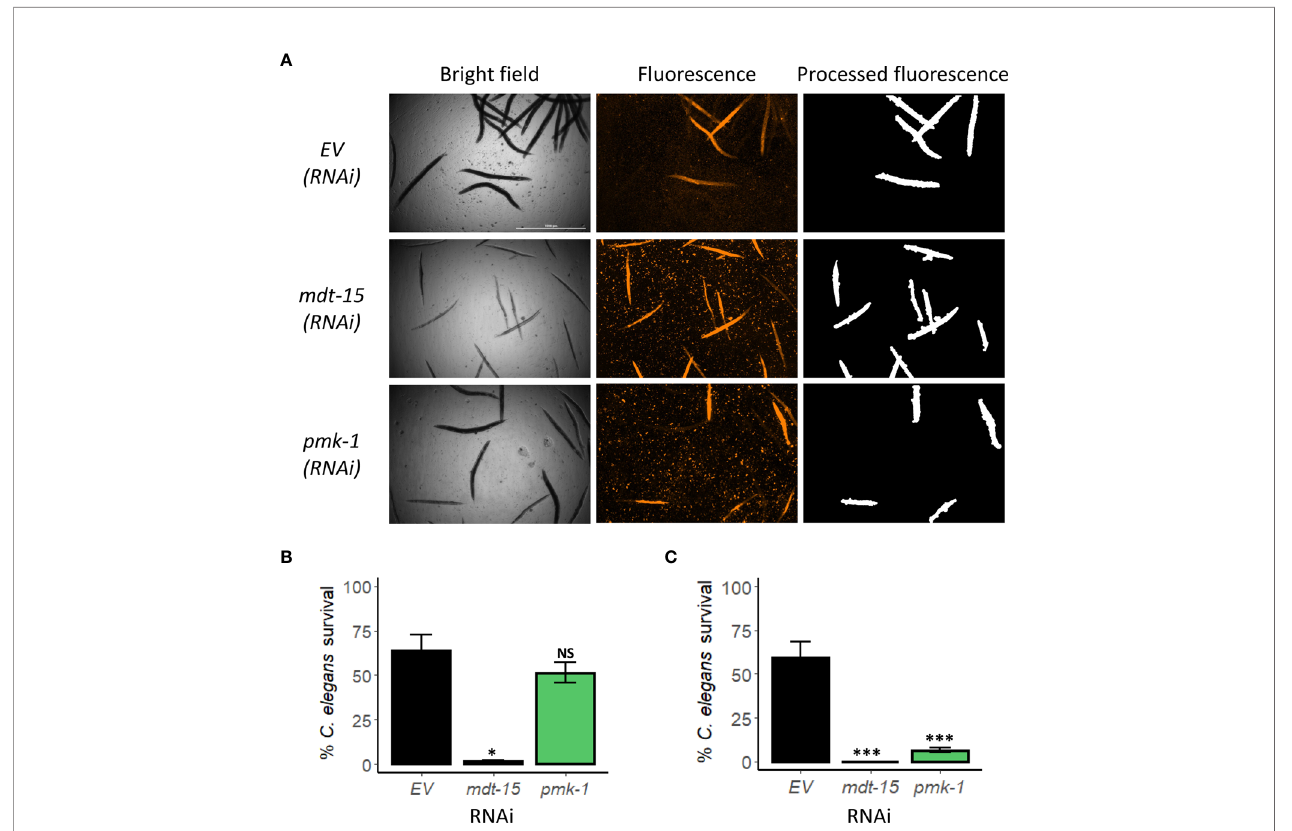
FIGURE 3 | PMK-1 did not confer resistance towards E. faecium in Enterococcus liquid-killing assay. (A) Fluorescence images and (B) quanti fi cation of C. elegans survival after exposure to E. faecium E007 in liquid. Worms were reared on E. coli expressing empty vector ( EV ) as control or mdt-15(RNAi) or pmk-1(RNAi) . (C) Quanti fi cation of C. elegans survival at 120 h exposure to E. faecium E007 in agar. Three biological replicates with ~400 worms/replicate for liquid-based assay or ~180 worms/replicate for agar- based assay were analyzed. Error bars represent SEM. p values were determined from Student ’ s t -test. NS not signi fi cant, * p < 0.05, *** p <